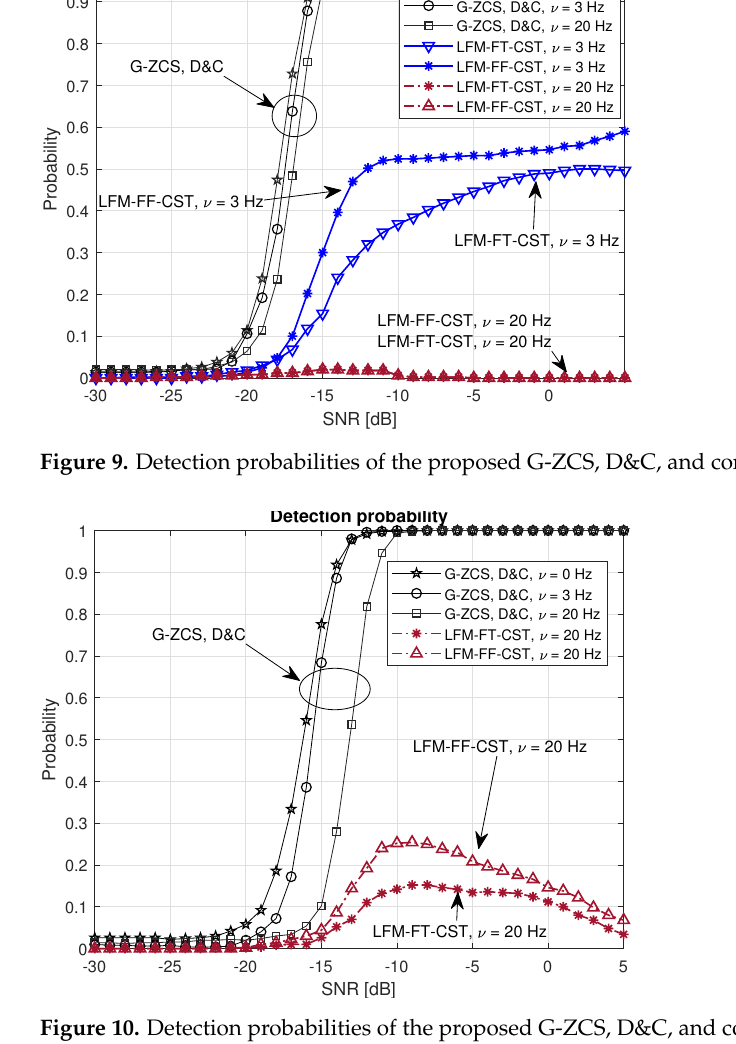
Figure 10. Detection probabilities of the proposed G-ZCS, D&C, and conventional CSTs (Bellhop). Computational